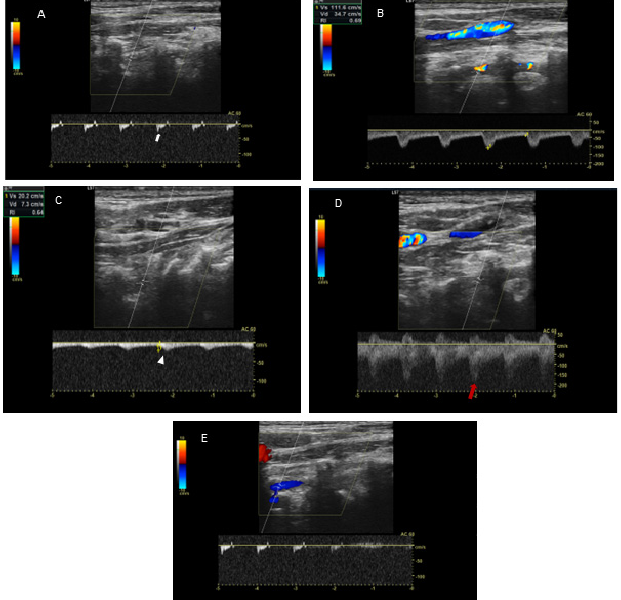
Figure 1. USGD in the neutral, left and right-side head rotations. Panel ( A ): USGD in the neutral position of the head demonstrates R-VA hypoplasia (width: 1.8 mm; N < 2–3 mm) with an increased blood flow resistance (PSV/EDV = 28/0 cm/s; RI = 1) (white arrow). Panel ( B ): USGD in the neutral position of the head demonstrates normal flow velocity in L-VA. Panel ( C ): USGD in left-side head rotation demonstrates post-stenotic flow velocity decline in L-VA (from 111/35 cm/s in neutral position to 20/7 cm/s in rotation; RI drop from 0.69 to 0.64)—the tardus and parvus wave ( white arrowhead ) . Panel ( D ): USGD in left-side head rotation demonstrates a turbulent flow in L-VA with increased up to 200 cm/s peek systolic velocity at C4 level ( red arrow ). Panel ( E ): USGD in right-side head rotation demonstrates no changes in the blood flow.